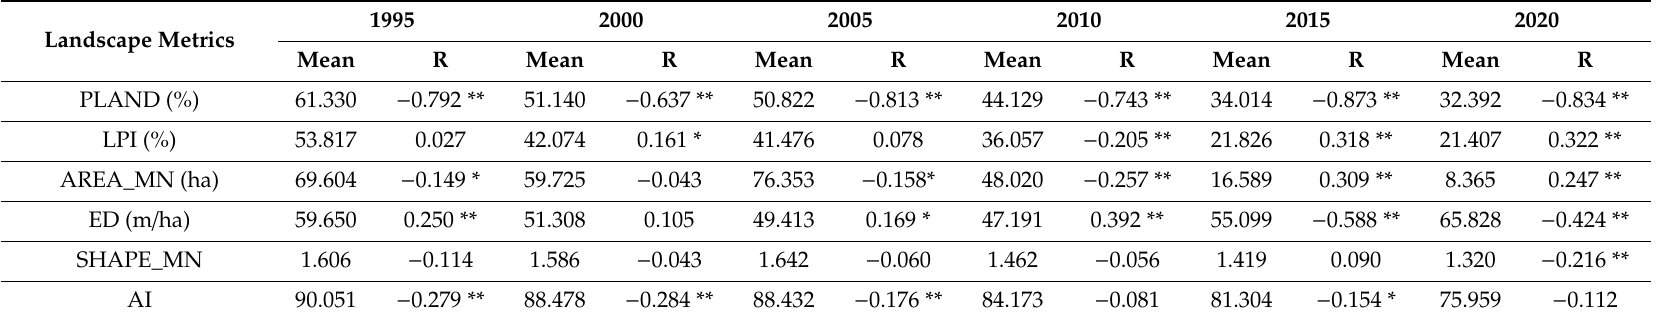
Table 8. Average values and correlations between spatial metric values and mean LST of green space patches. Landscape